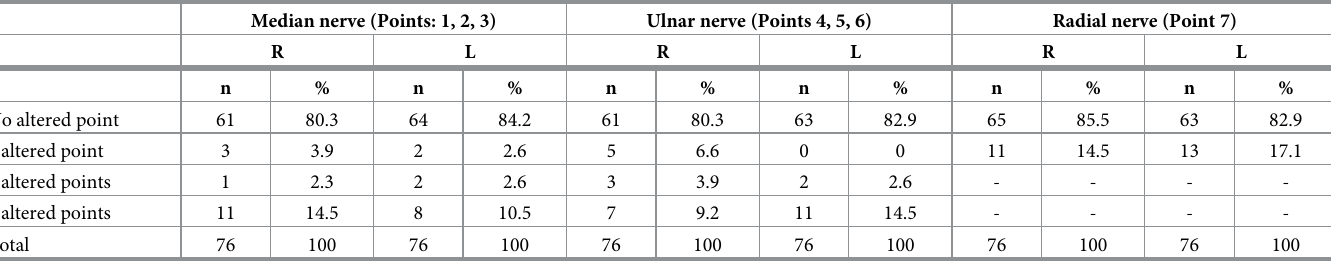
Table 8. Distribution of the number of SWM-test (normal and altered) points of the hands per patient at the end of the treatment and corresponding nerves. Median nerve (Points: 1, 2, 3)